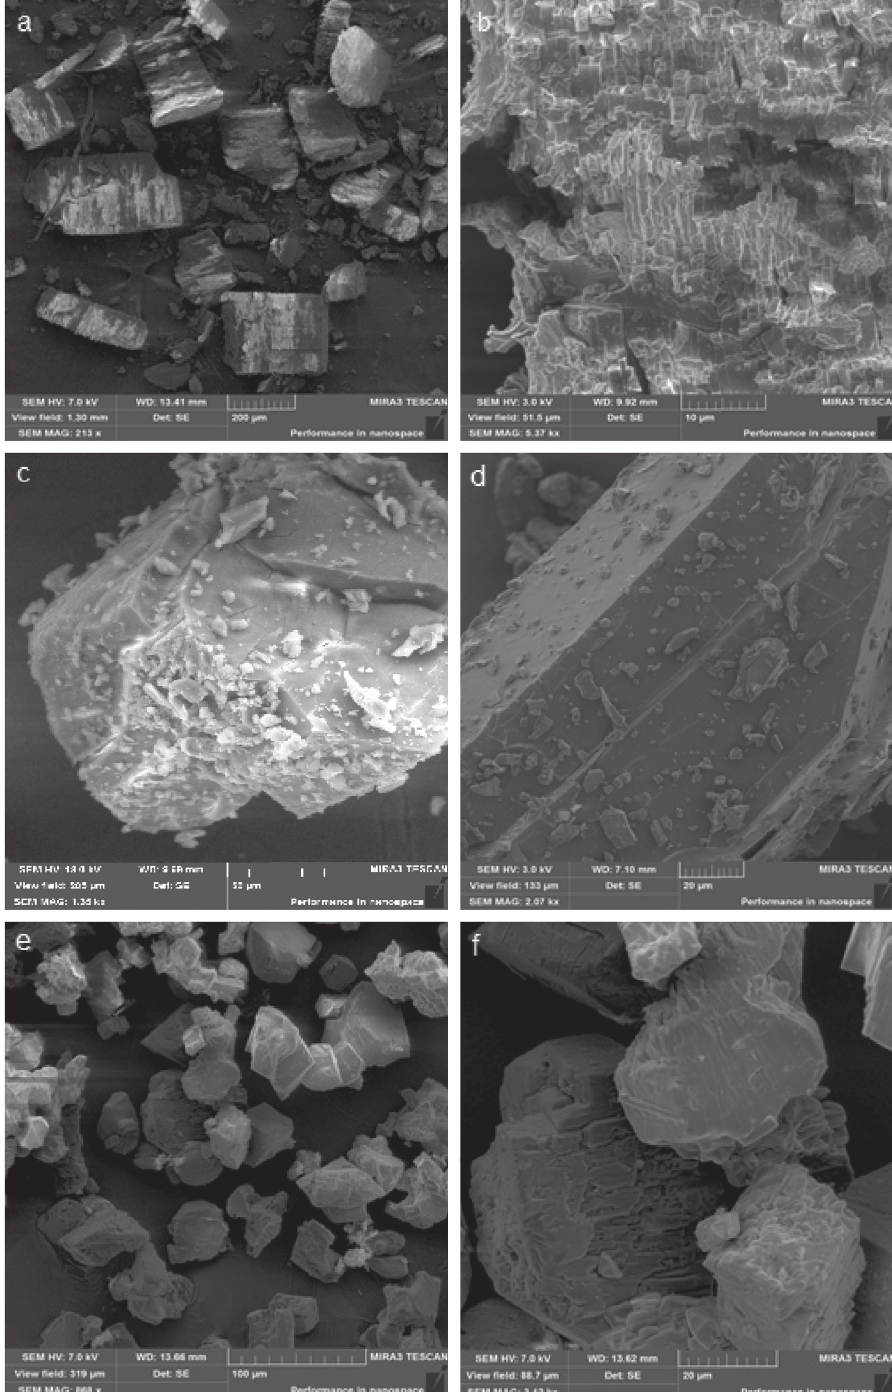
Figure 3: Scanned electron micrographs of β -cyclodextrin (a, b), a physical mixture of β -CD with VD complex (2:1) (e, f) at various